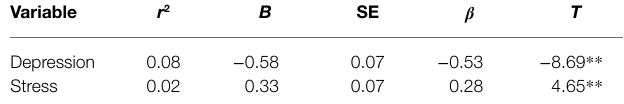
TABLE 4 | Stepwise multiple regression of predictors of psychological wellbeing (only significant predictors are shown). Variable